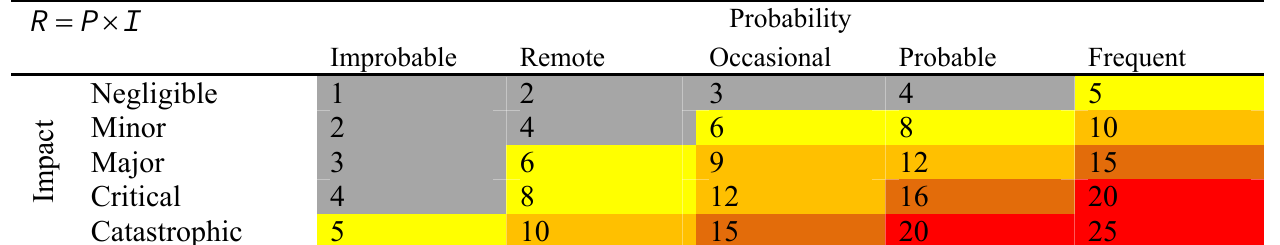
P-I risk matrix (Parker,